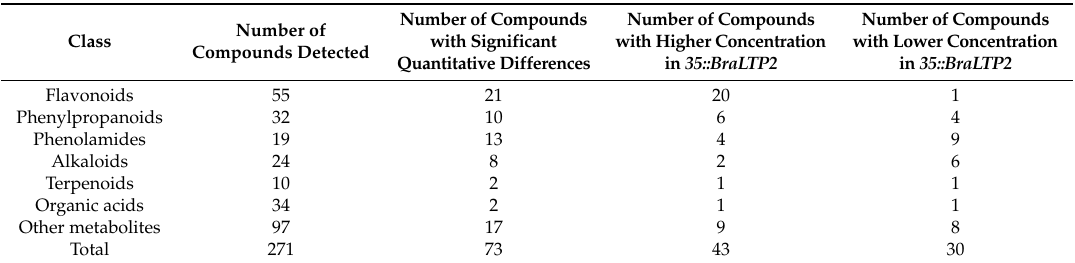
Table 2. Seven main categories of the secondary metabolite in the wild type (WT) and 35::BraLTP2- overexpressed